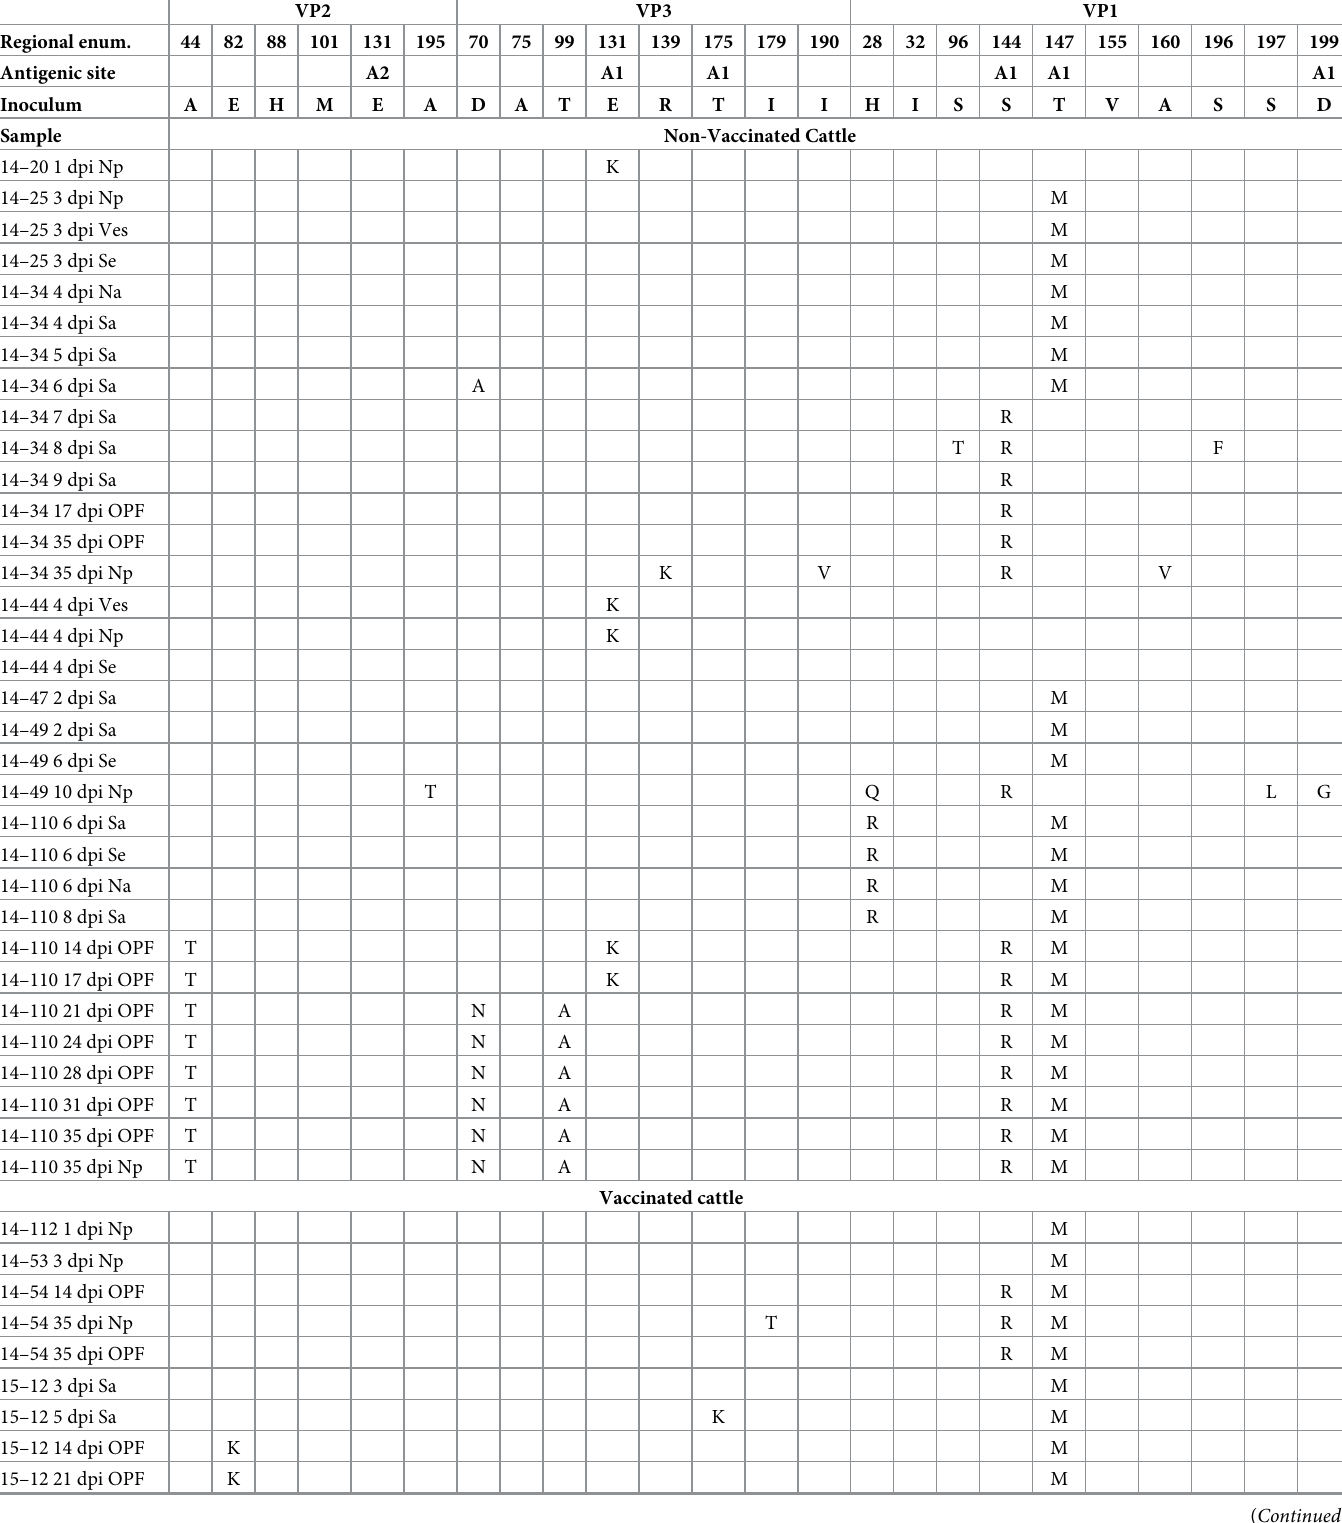
Table 3. Amino acid substitutions in FMDV capsid surface proteins. VP2 VP3 VP1 Regional